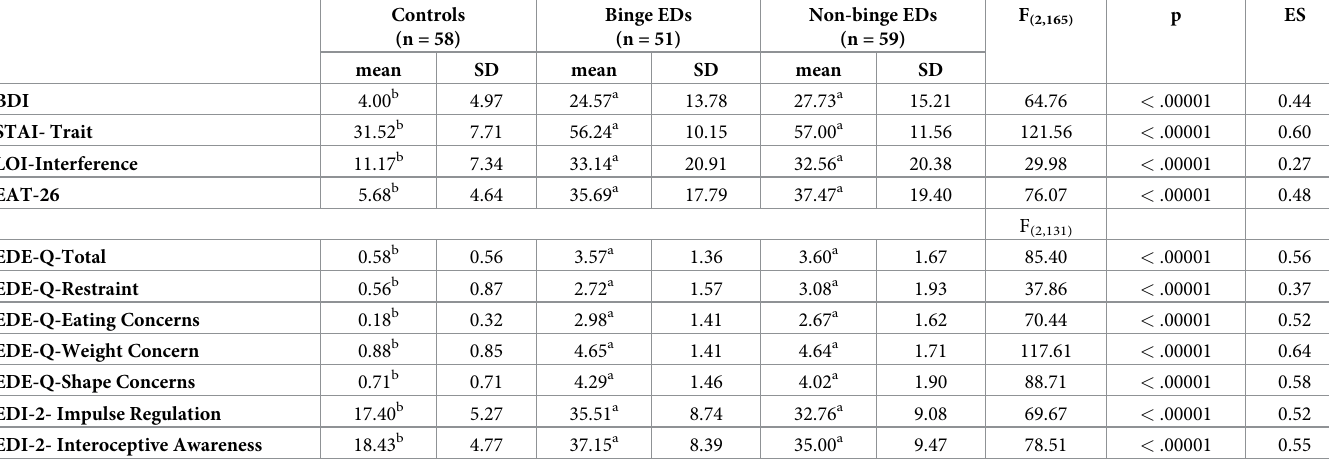
Table 2. Psychometric variables: Three-group analysis